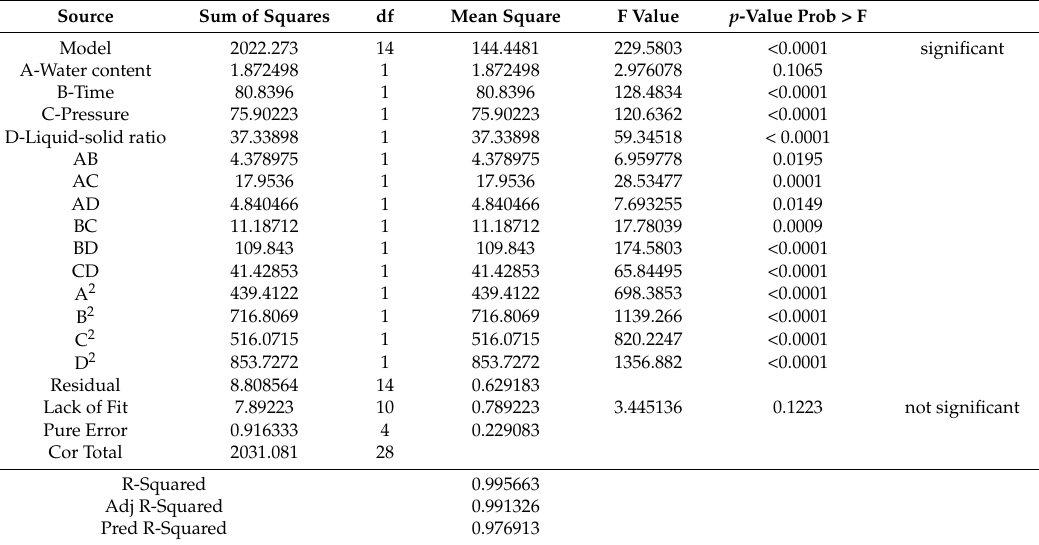
Table 5. Box–Behnken design with independent variables and measured